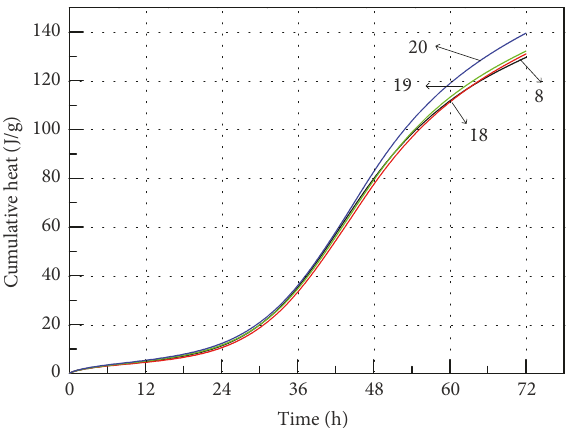
Figure 21: Cumulative heat versus time of references with SRA-